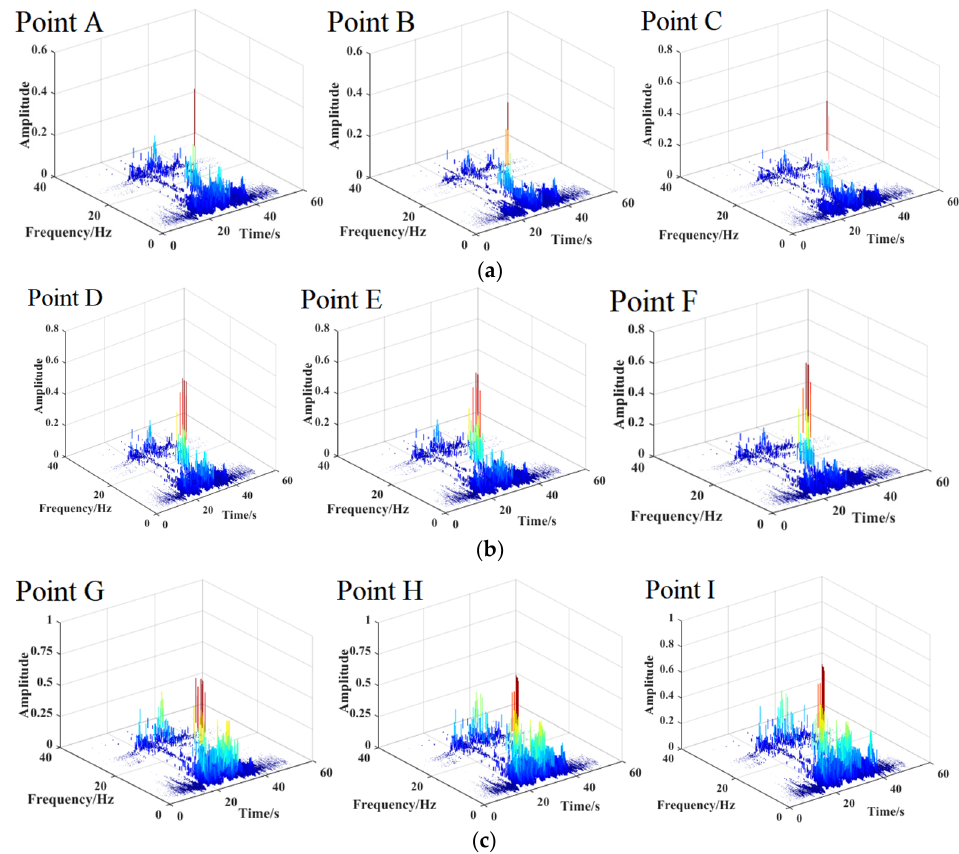
Figure 15. Seismic Hilbert energy spectrum of different strata of Model 2: ( a ) layer 1, ( b ) layer 2, ( c ) layer 3.